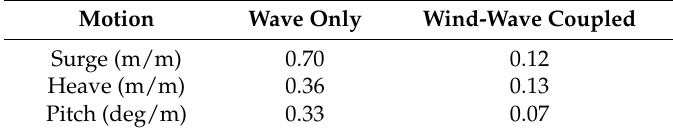
Table 7. Motion response amplitude operators (RAOs) in different environment conditions.